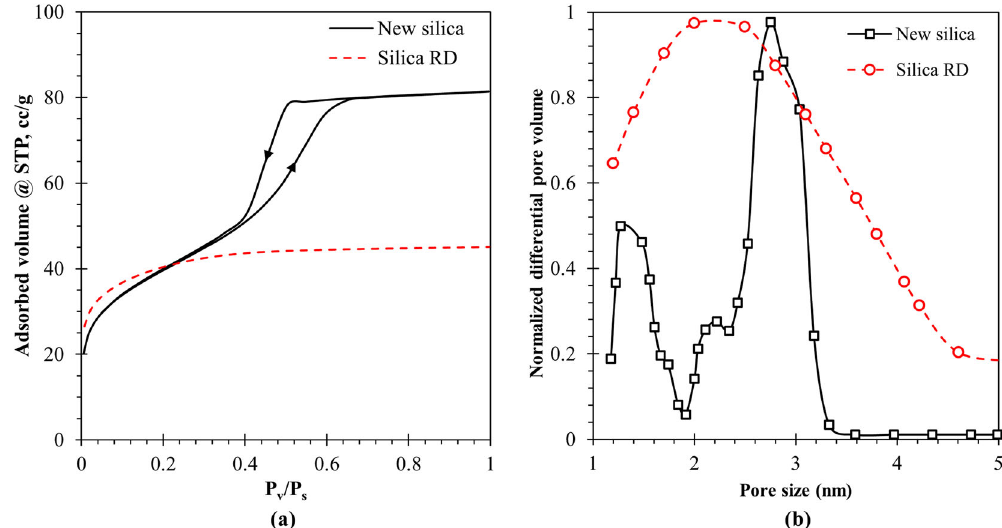
Fig. 1 N 2 gas adsorption method. a N 2 adsorption isotherm of the new silica and silica RD at 77 K, and b the normalized pore size distributions of the two tested adsorbents, showing two peaks at around 1.27 (micropores) and 2.75 nm (mesopores) for the developed silica and wide distribution for silica RD.